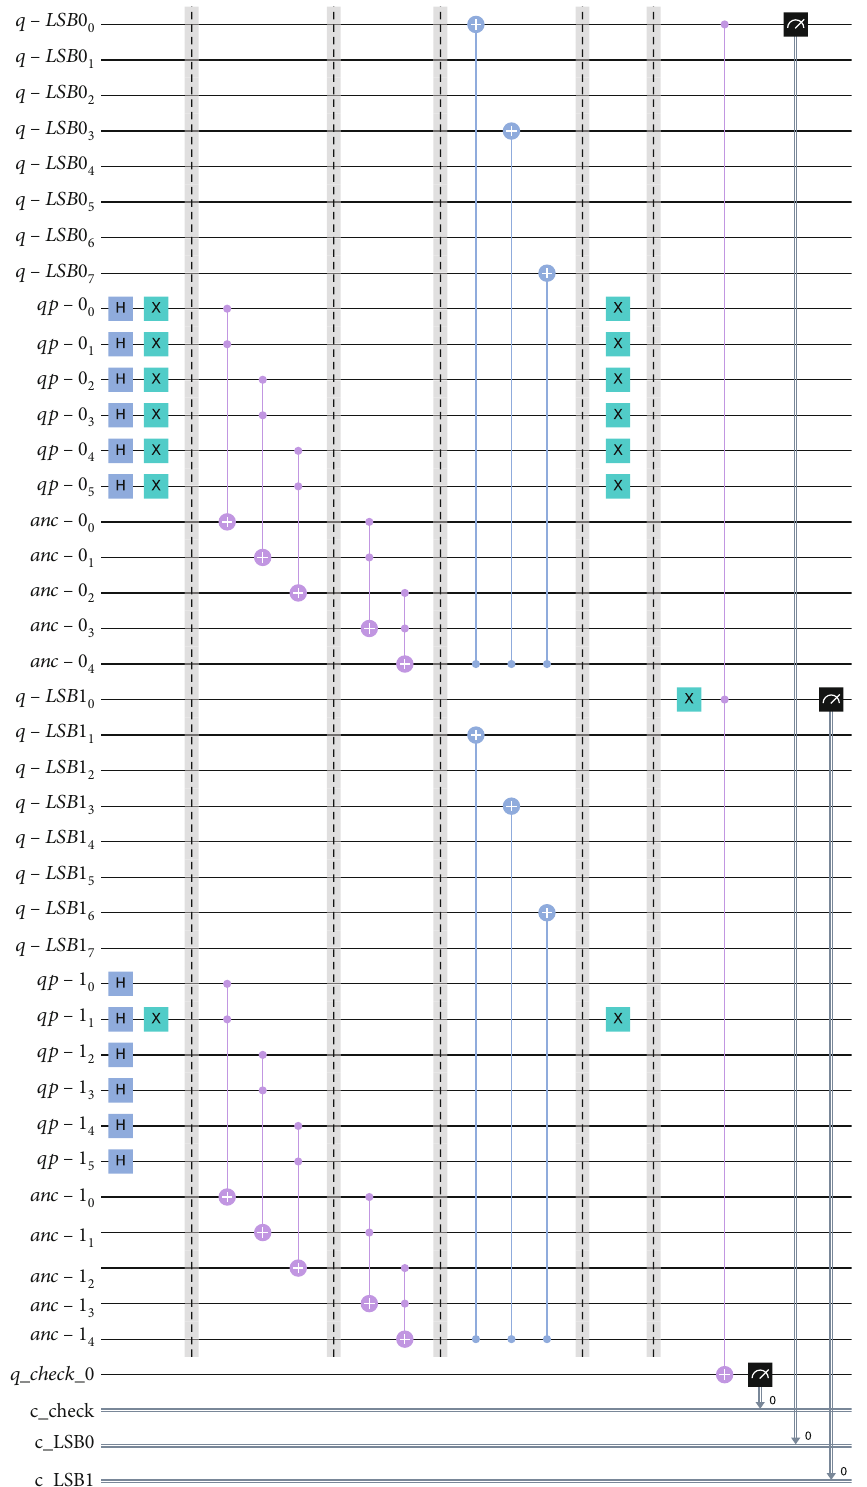
Figure 7: The NEQR representation of the two pixels describing Alice ’ s vote: q -LSB0 (quantum register with 8 qubits) for the pixel in the upper-left corner (value 137) and q -LSB1 (quantum register with 8 qubits) for the pixel in the lower-right corner (value 74). Qubit q check , which belongs to the server, is set to state j 1 i when the control qubits of the last To ff oli gate (after the second barrier) are both in state j 1 i (so the voter has to con fi gure his part of the circuit according to his vote and add, if necessary, NOT gates for q -LSB0 particular situation, the voter added a NOT gate for q -LSB1 and